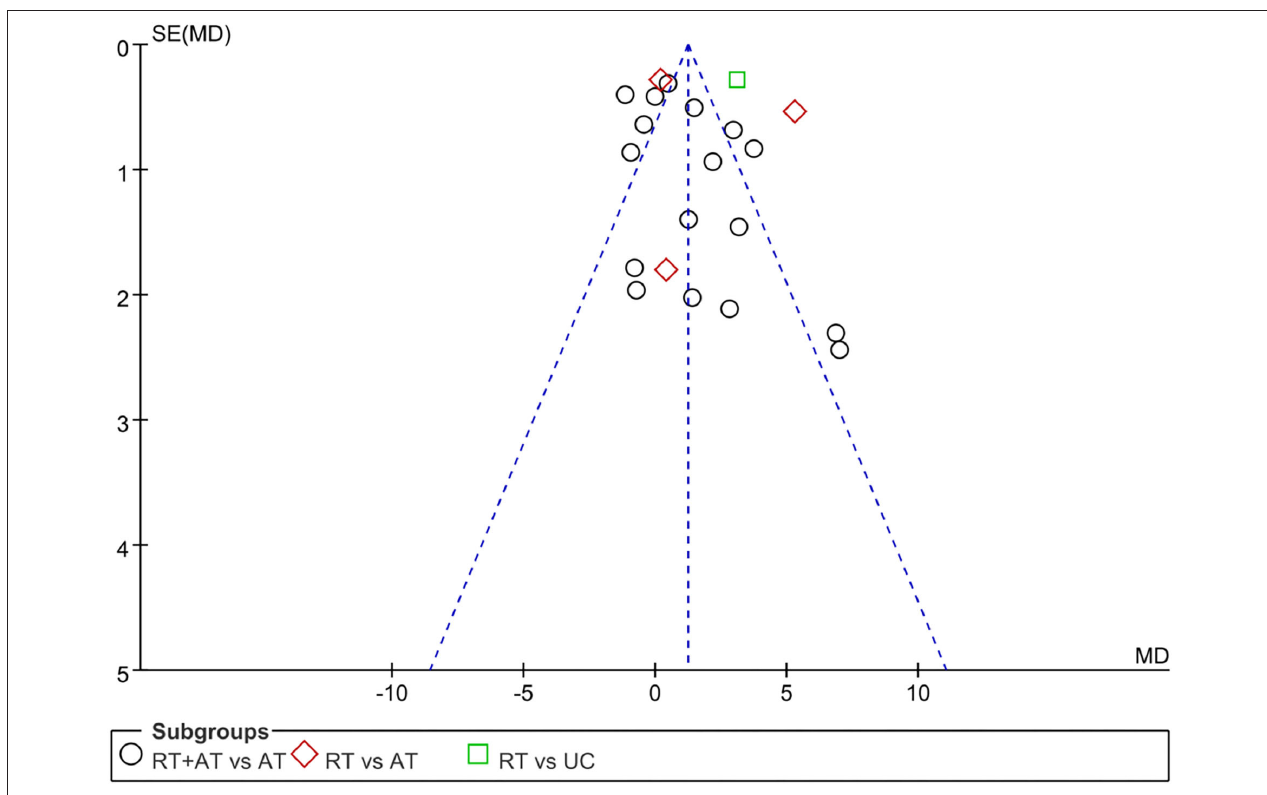
FIGURE 5 | Funnel plot of publication